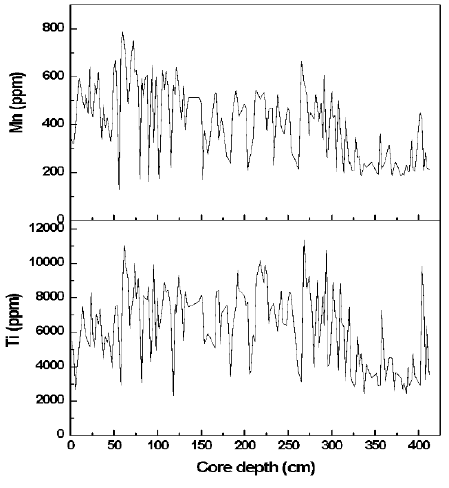
Figure 3: Down core variations of Ti and